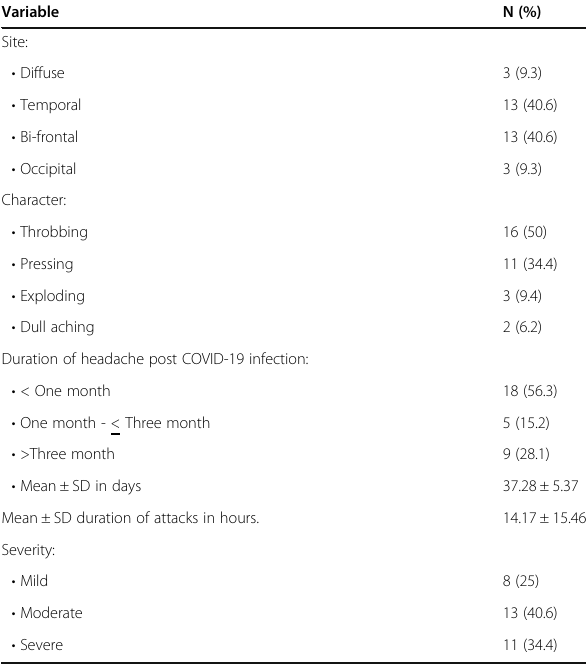
COVID-19 Coronavirus disease-19, SD standard deviation, N